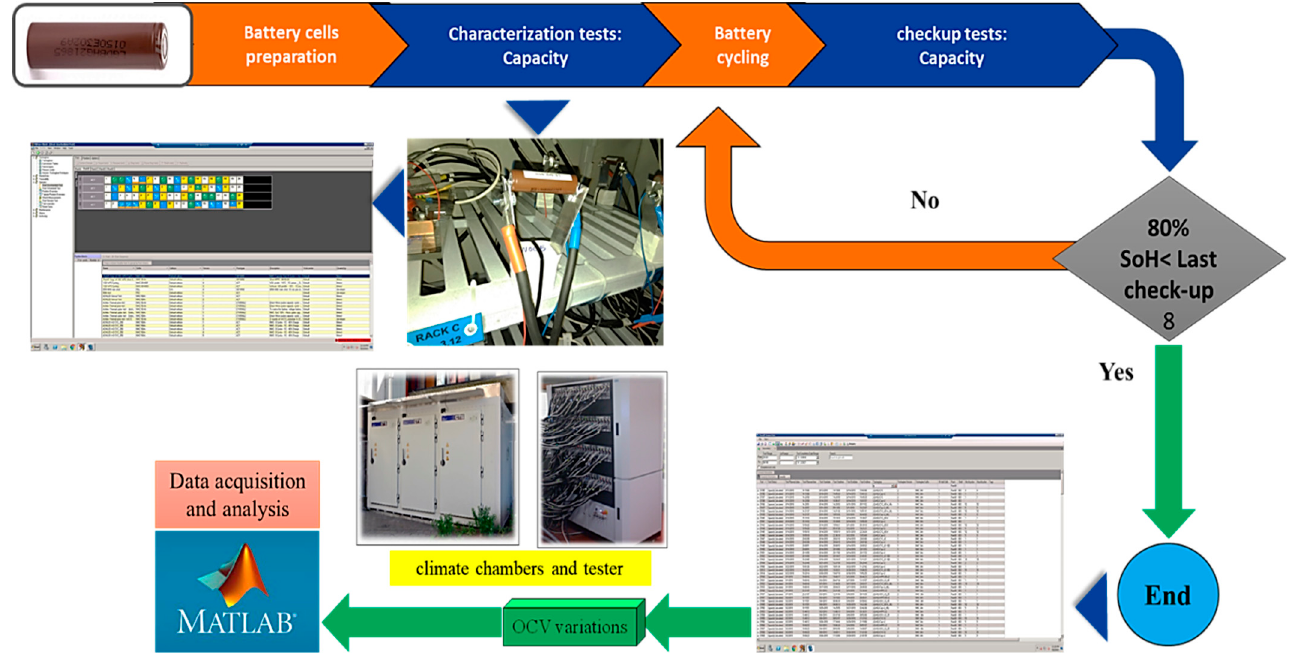
Figure 3. Proposed workflow of the case study used to investigate the OCV variation of a Li-ion battery.